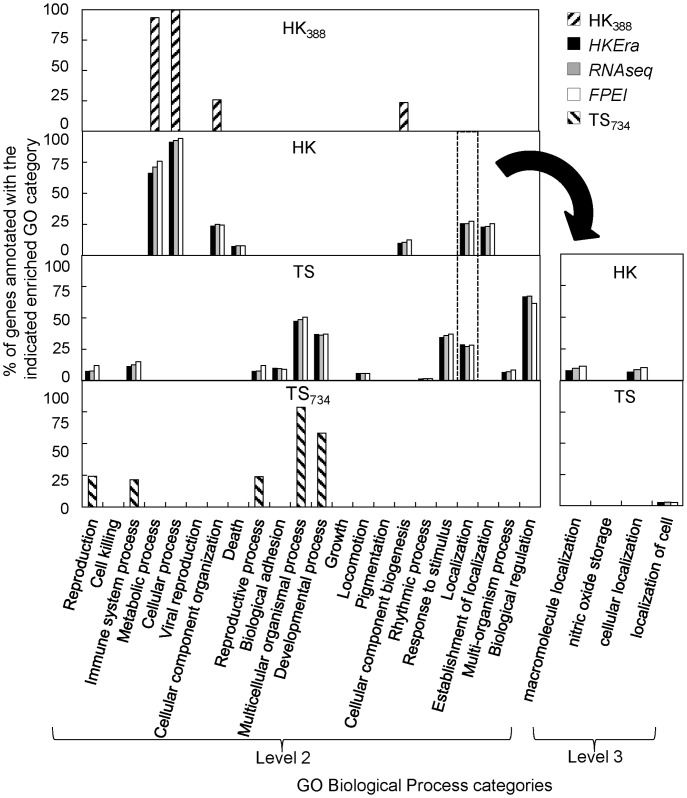
Percentage of genes annotated with the indicated GO term in different HK and TS sets.The figure shows the percentages of genes annotated with the indicated enriched GO category (determined using FDR-corrected p<0.05) in the indicated HK or TS gene set. Genes not associated with any enriched GO term were not used to compute the percentage. At GO’s level 2 (left graph), ‘Localization’ (GO: 0051179) was the only enriched BP category common to both the HK and TS sets; however, at the next level (level 3) of this category (right graph), the enriched GO terms for the two gene sets were different. Note that, “cellular localization (GO: 0051641)” and “macromolecule localization (GO: 0033036)” denote that a protein or macromolecule is transported to a specific location in a cell, while “localization of cell (GO: 0051674)” denotes that a cell is transported to a specific location [40]. Similar results were obtained for the analysis using GO Cellular Component (CC) (Figure S4 in File S1) and Molecular Function (MF) categories (Figure S5 in File S1).